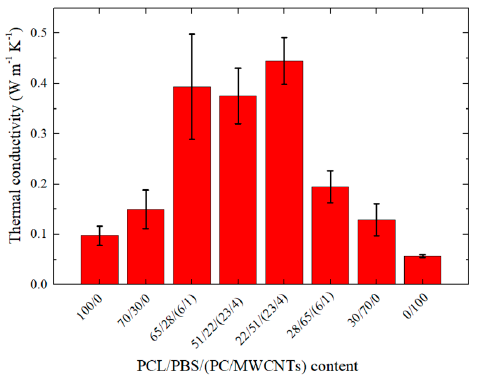
Figure 8. Influence of PC/MWCNTs masterbatch content on the thermal conductivities of the nanocomposites.